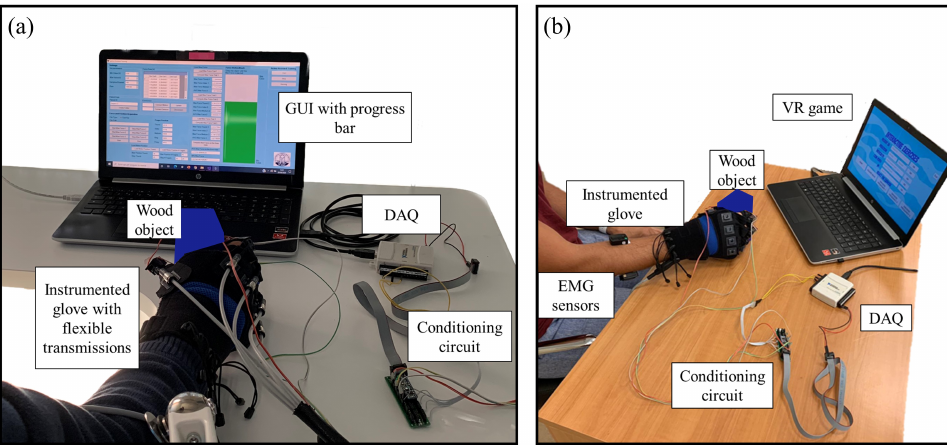
Figure 5. ( a ) Experimental setup for the active-assisted training; ( b ) experimental setup for the virtual reality game: electromyographic (EMG) sensors are positioned on the flexor digitorum superficialis and extensor digitorum communis